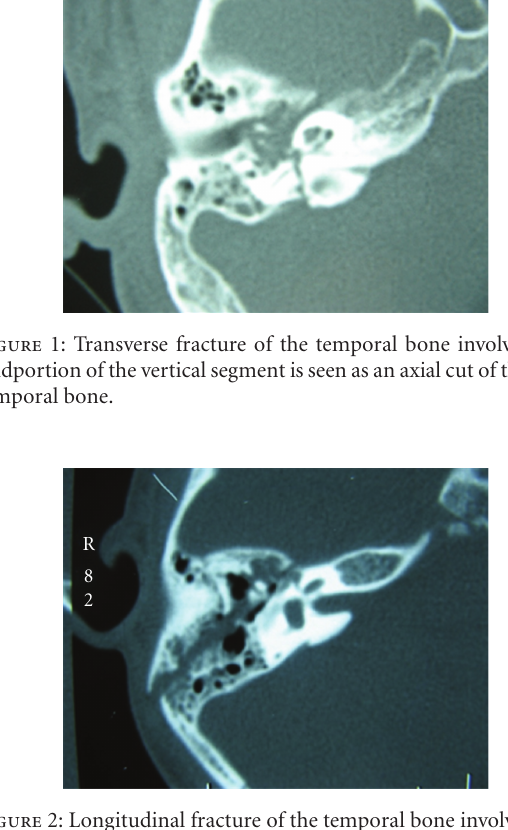
Figure 2: Longitudinal fracture of the temporal bone involving the perigeniculate region is seen as an axial cut of the right temporal